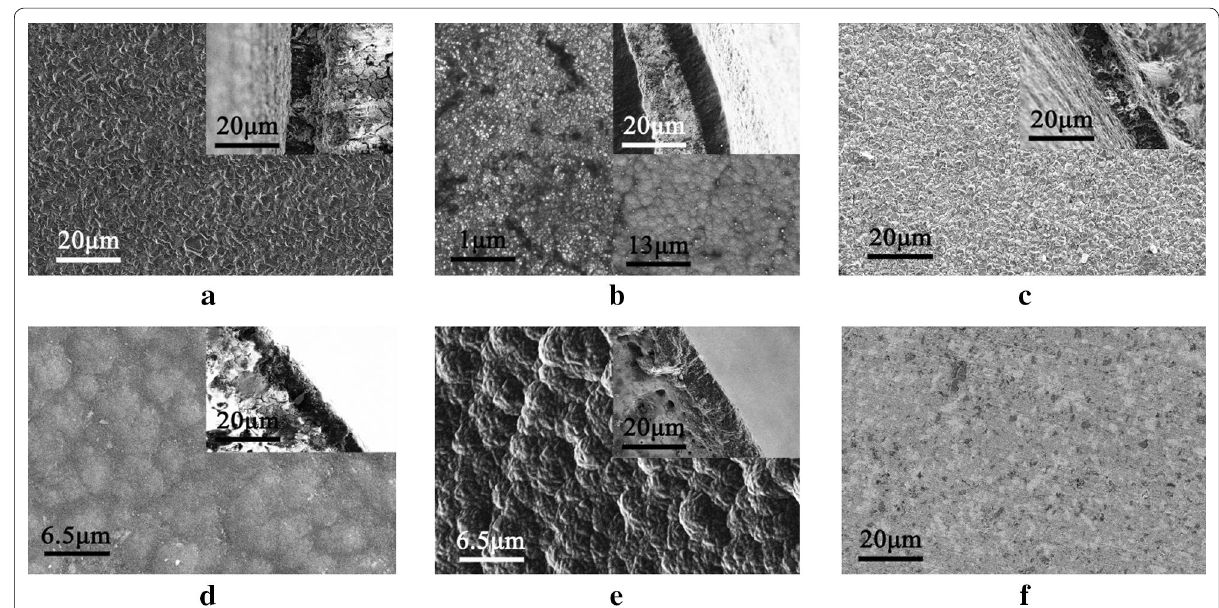
Figure 3 FESEM micrographs of a PMCD, b PFGD, c BDMCD, d BDFGD and e BDM‑PFGCD coated milling cutters before AFM, and f the uncoated milling cutter